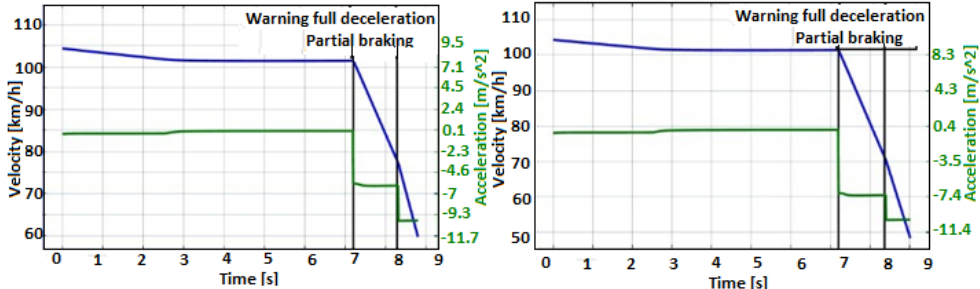
Figure 6. Speed profiles of ego-vehicle. Maximum braking pressure to use when partial braking increased to 50% and 60%.